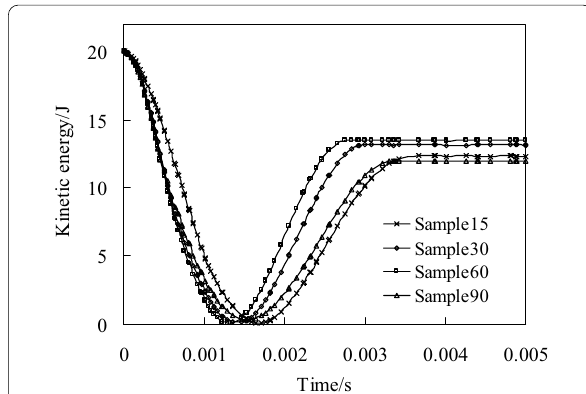
Fig. 11 Change history of kinetic energy of the four models when the impact energy is 20 J